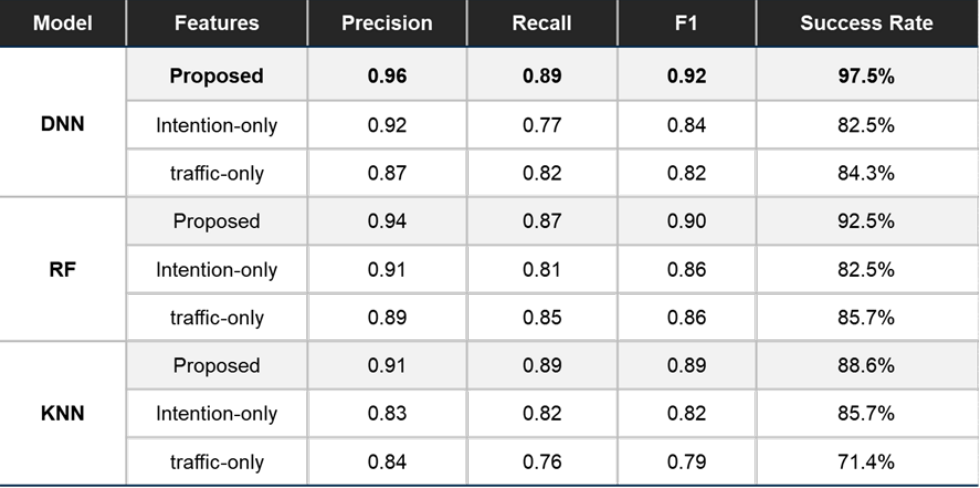
Figure 13. Quantitative evaluation